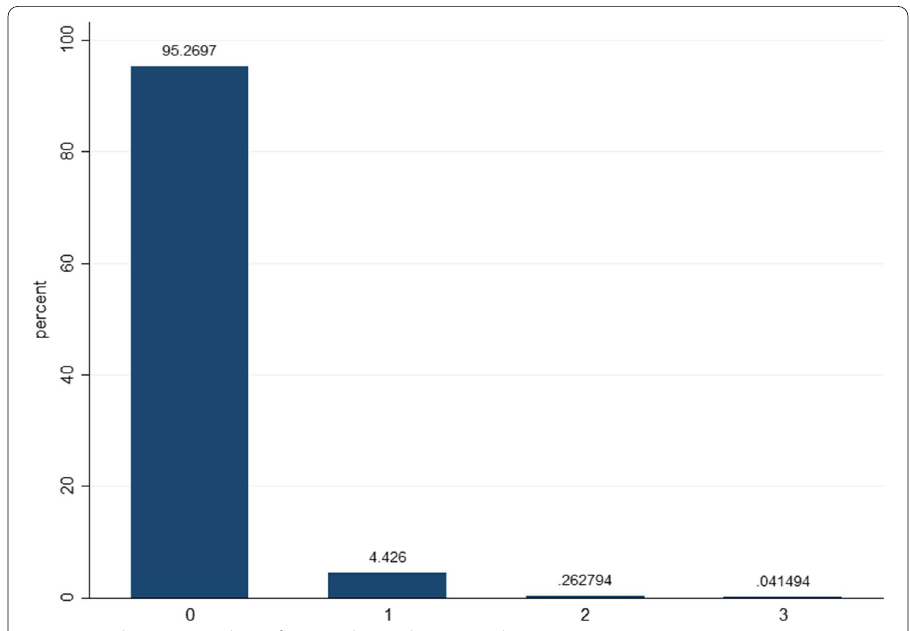
Fig. 1 Distributions (number) of perinatal mortality per